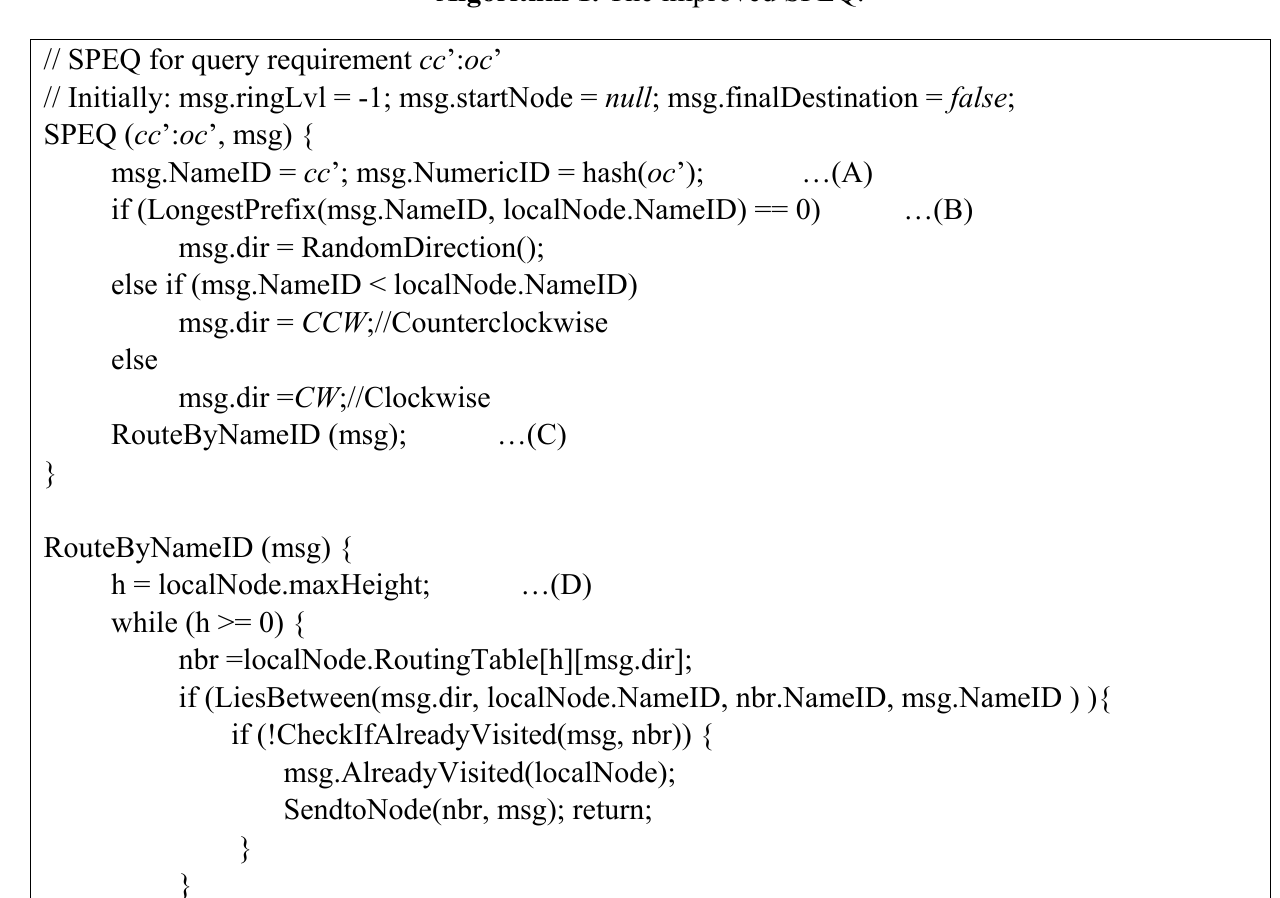
Algorithm 1. The improved